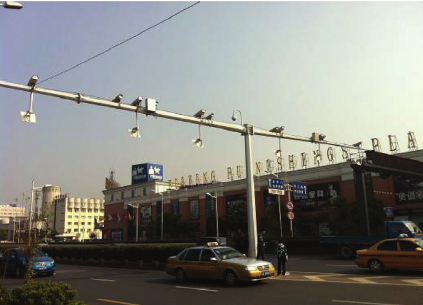
Figure 1: Overall layout diagram.